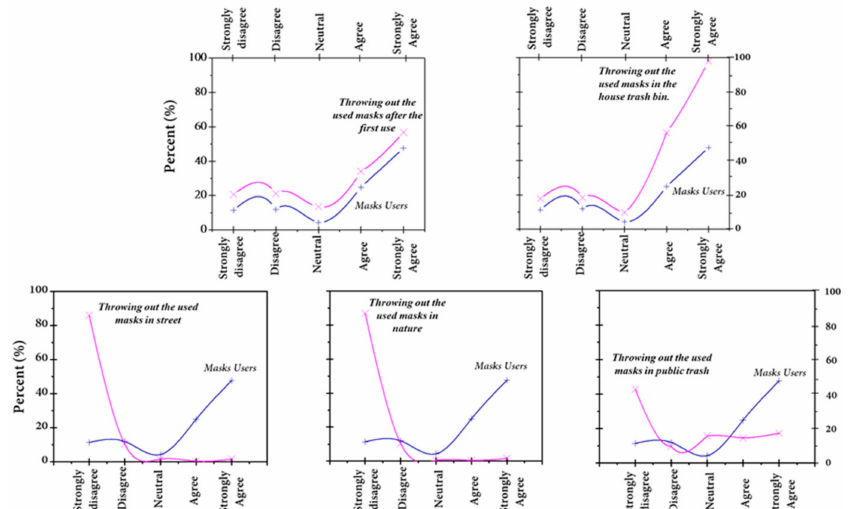
Figure 10. Management of discarded masks by the